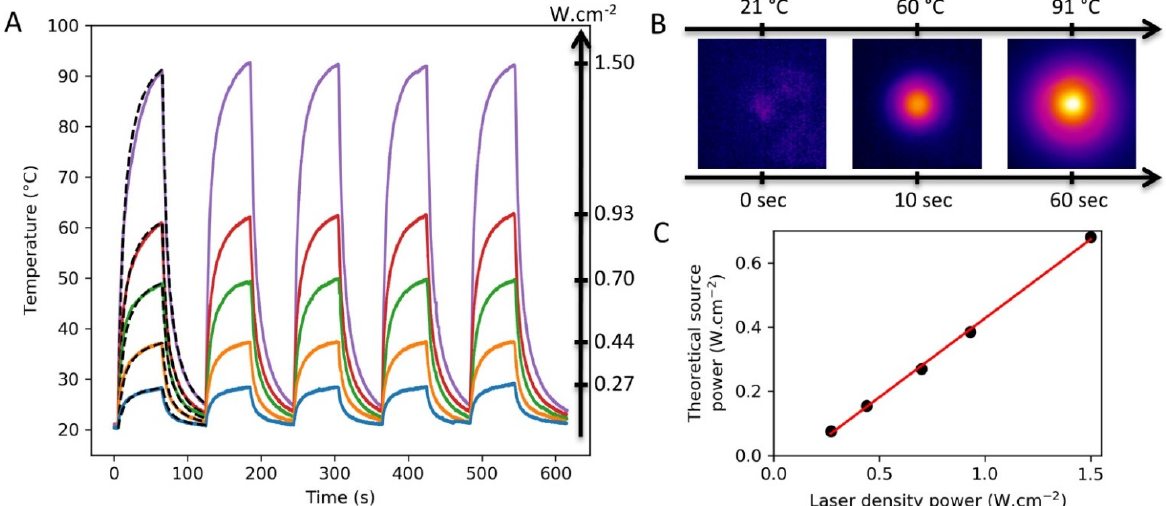
Figure 10. ( A ) Experimental and simulation results of PB surface laser heating (λ ir = 808 nm). The plain lines represent the experimental PTT data obtained with sample 2c for different values of the laser power density represented by the left arrow. The dashed lines represent the simulation results with a density power source of 0.075, 0.155, 0.270, 0.385, and 0.680 W.cm −2 , which were adjusted using the 0.27, 0.44, 0.70, 0.93 ,and 1.50 W.cm −2 experimental curves, respectively; ( B ) Ther- mal camera images of sample 2c under laser irradiation of 1.50 W.cm −2 ; ( C ) Theoretical density power source obtained from the simulations as a function of the laser density power; the plain line is a linear regression fit.